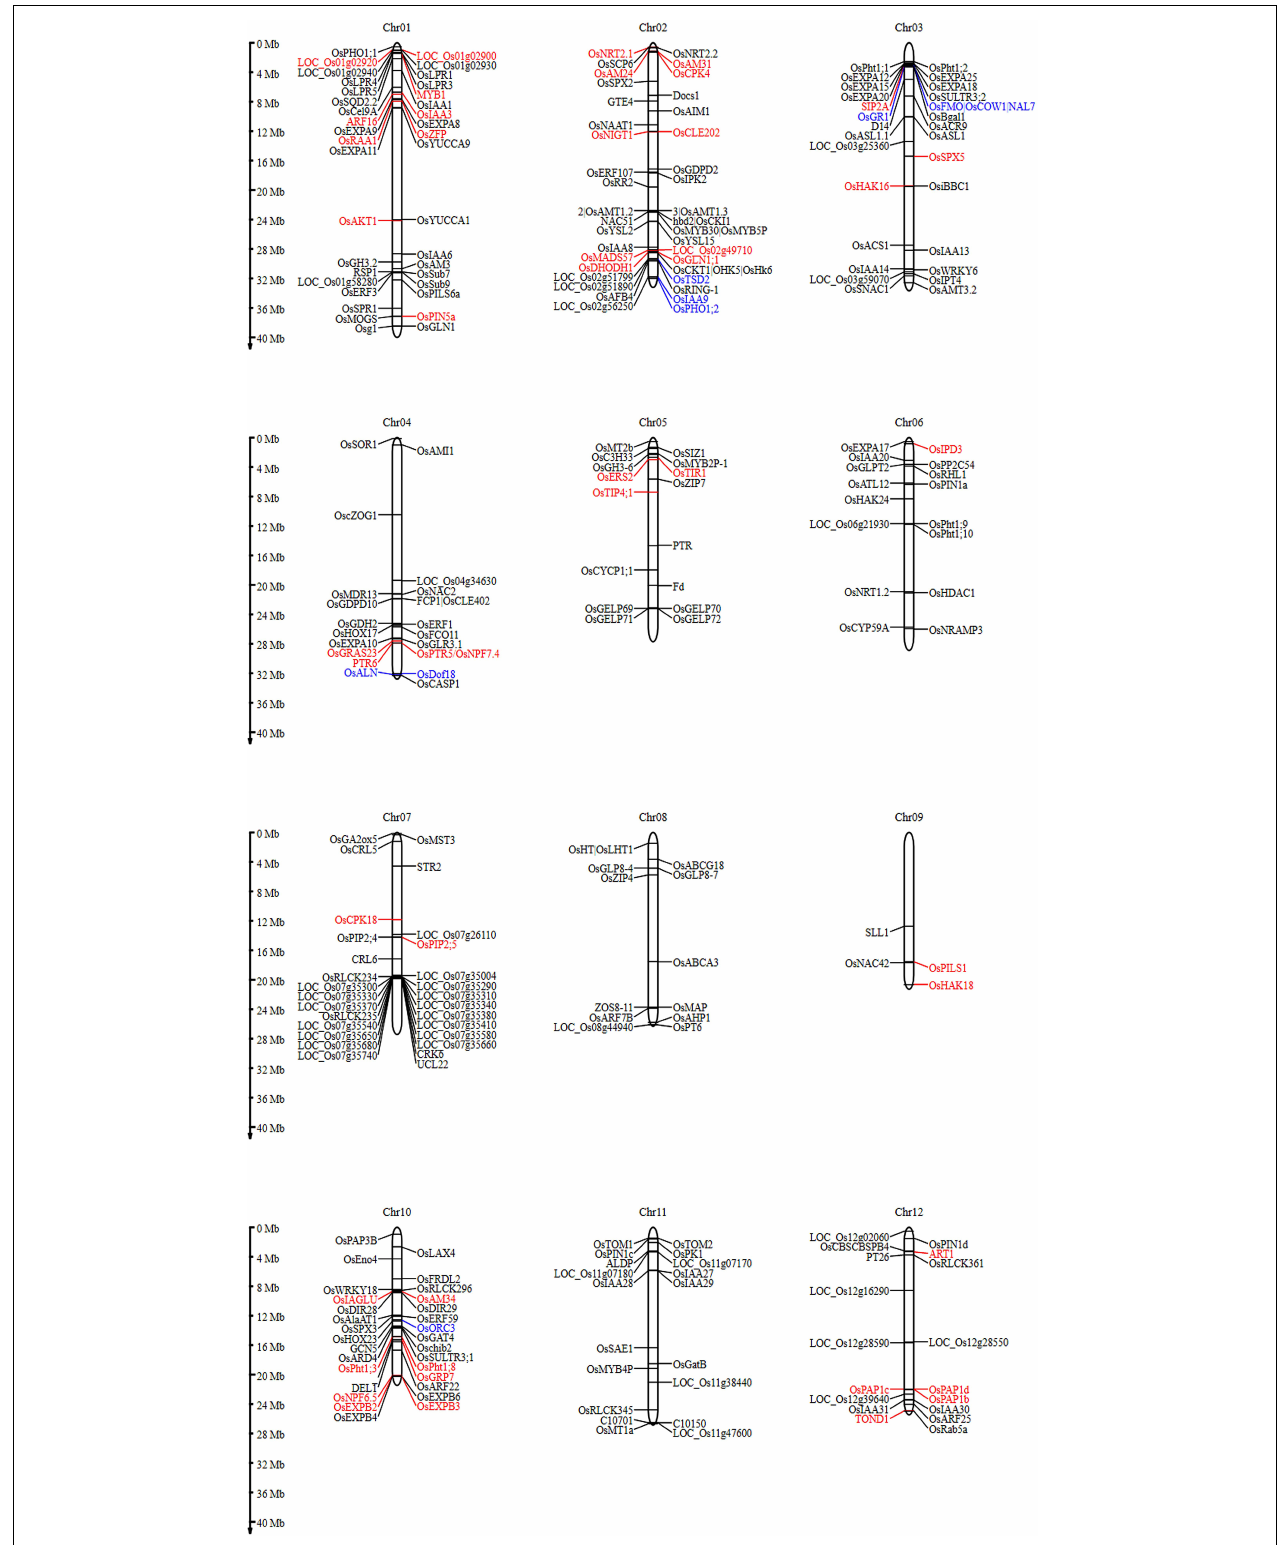
FIGURE 12 | Root architecture and nutrient acquisition genes involved in young rice seedlings under DSR conditions detected in this study were presented in 12 chromosomes. Candidate genes found in multiple traits and across seasons were indicated by red and blue fonts, respectively.